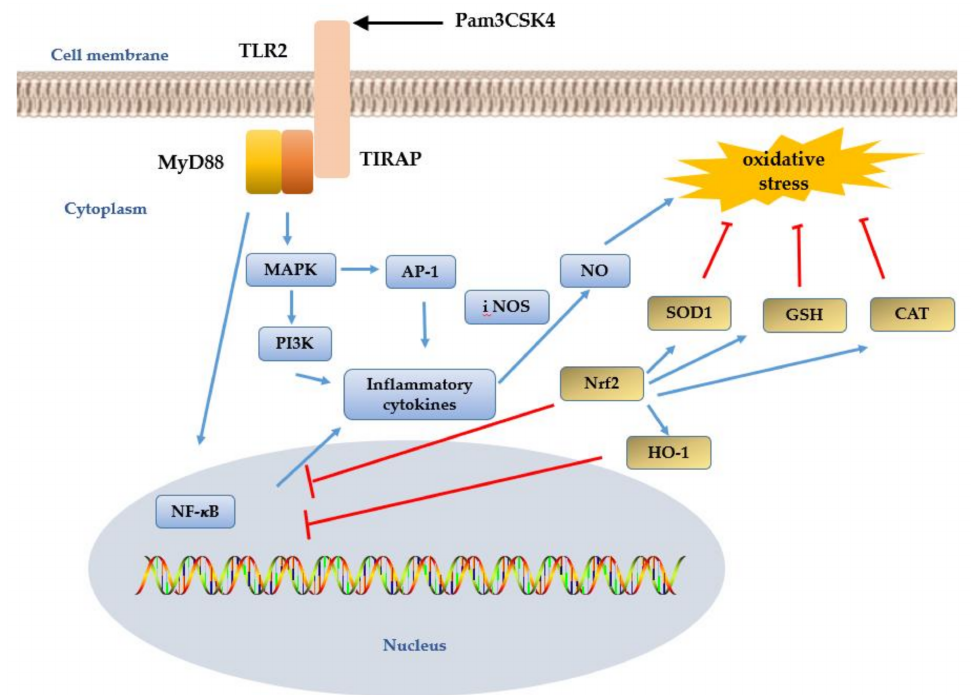
Figure 2. The TLR2 signal pathway involved in oxidative stress [48,55]. The TLR2 signaling pathway activates the MYD88 pathway to activate the NF- κ B and MAPK pathways under the action of the ligand Pam3CSK4. Phosphorylation of MAPK then activates transcription factor activator protein-1 (AP-1) and PI3K / protein kinase signaling pathways to induce an immune response. AP-1 is a transcription factor that mediates pro-inflammatory factors, and NO (cid:8) levels are regulated by iNOS. Nrf2 can induce